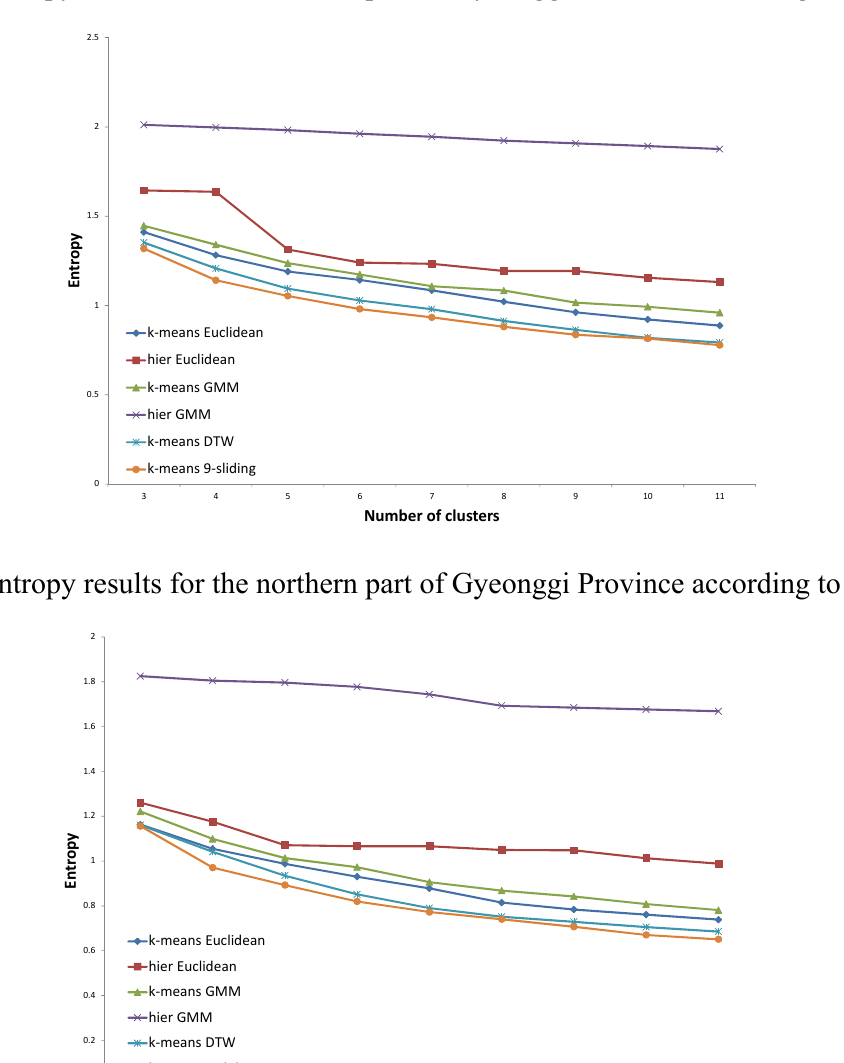
Figure 8. Entropy results for the southern part of Gyeonggi Province according to expert #2.